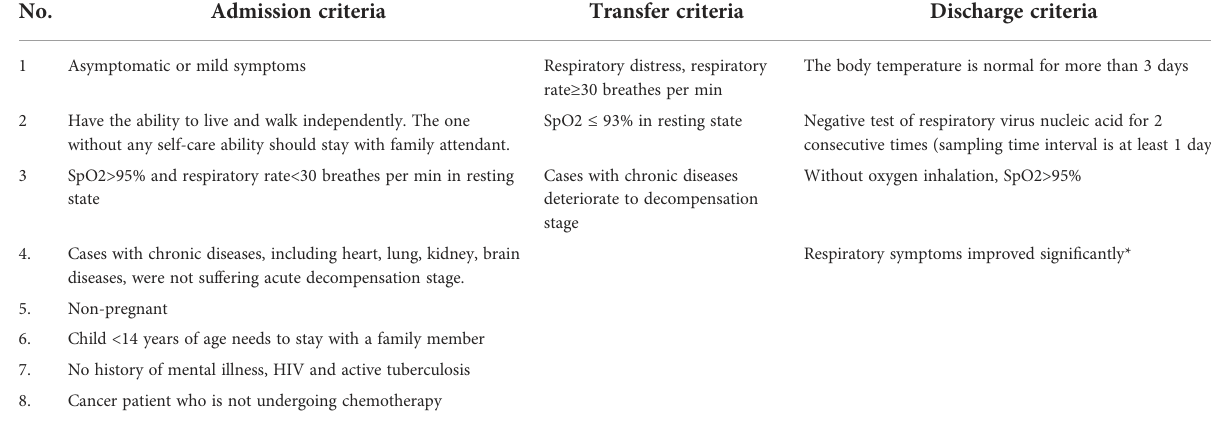
TABLE 1 The criteria for patient admission, transfer and discharge in Lingang